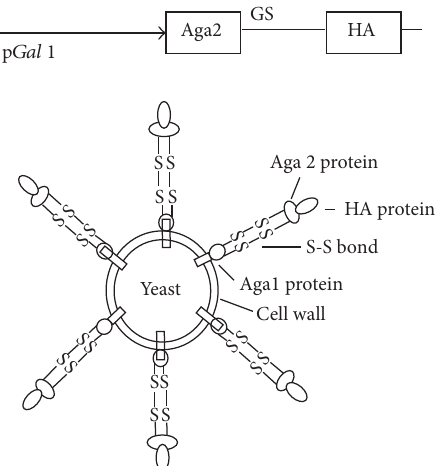
Figure 1: Functional display of HA on yeast surface. A schematic diagramofHAdisplayonyeastsurface.TheAga2-HAfusionprotein binds to Aga1 through two disulfide bonds after its secretion from the yeast. Aga1 is the first subunit of the yeast a-agglutinin receptor. It is secreted from the cell and becomes covalently attached to 𝛽 - glucan in the extracellular matrix of the yeast cell wall. A GS linker is inserted between Aga2 and HA to stabilize the fusion protein